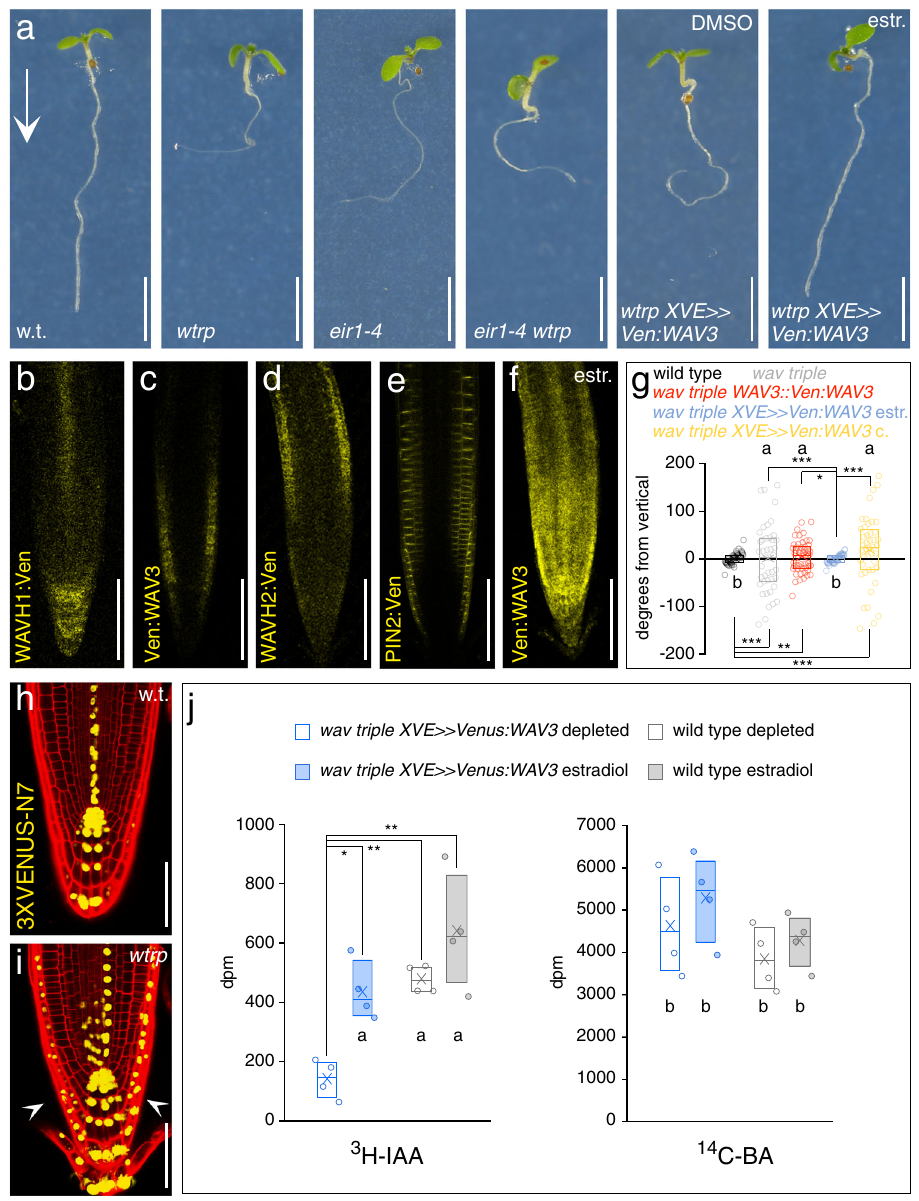
Fig.1|Arabidopsis WAV3/WAHV genesactinrootgravitropismandpolarauxin transport in root meristems. a Comparison of wild type (w.t.), wav triple ( wtrp ), eir1-4 , eir1-4 wav triple , wav tripleXVE»Ven:WAV3 inpresenceof solvent (DMSO) or 2 μ M estradiol. 5 DAG seedlings grown on vertically oriented plates are on display. Arrow indicates gravity vector. Reporter signals in WAHV1::WAVH1:Ven ( b ), wav triple WAV3::Ven:WAV3 ( c ), WAHV2::WAVH2:Ven ( d ), eir1-4 PIN2::PIN2:VEN ( e ) and wavtripleXVE»Ven:WAV3 inpresenceof2 μ Mestradiol( f ).Rootsof5DAGseedlings are on display. g Orientation of root tips, expressed as degrees deviation from vertical of 5 DAG wild type ( n =46 roots/3 experiments), wav triple ( n =44 roots/3 experiments), wav triple WAV3::Ven:WAV3 ( n =52 roots/3 experiments), wav triple XVE»Ven:WAV3 seedlingsgrownonsolvent(DMSO, ‘ c. ’ ; n =43roots/3experiments) or in presence of 2 µ M estradiol ( ‘ estr. ’ ; n =54 roots/3 experiments). Expression